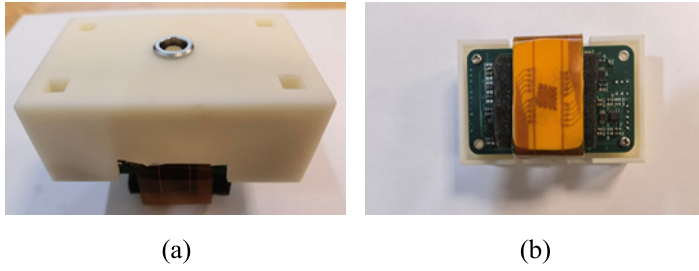
Figure 3. Photographs of the prototype probe: ( a ) top view and ( b ) bottom view.